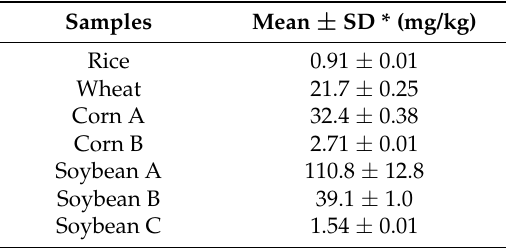
Table 3. Concentrations of selenium in seven cereals or soybean samples obtained from Se biofortified agricultural products ( n =